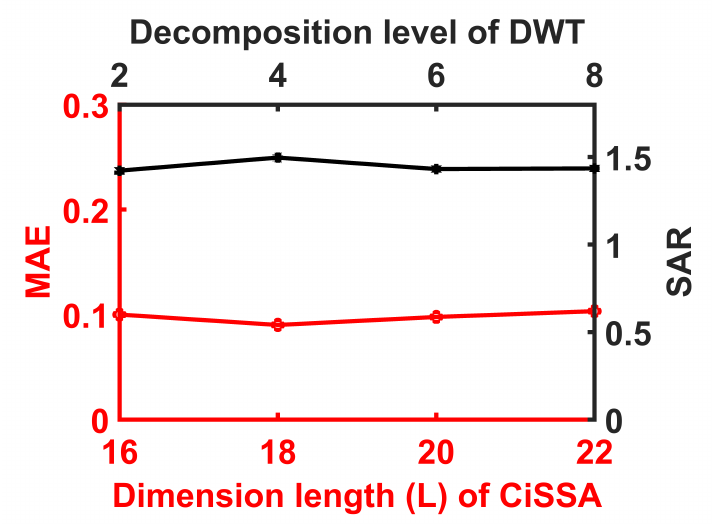
Figure 10. Plot shows variance of MAE and SAR values of CiSSA-DWT tuning